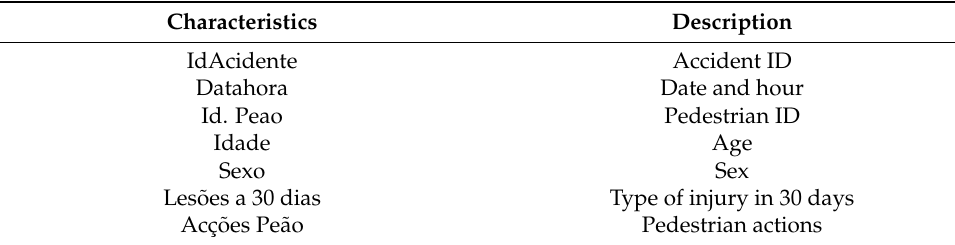
Table 6. Pedestrians’ data schema.